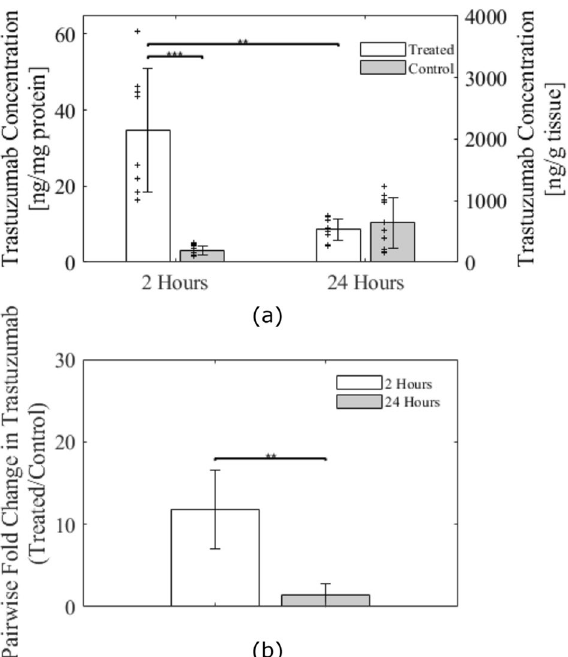
Figure 4. ELISA results for trastuzumab concentration in healthy rat spinal cord tissue. ( a ) Comparison between FUS-targeted regions and untargeted regions at 2-h post-FUS and 24-h post-FUS. Individual data plotted as ‘ +’ scatter points. ( b ) Fold increase in trastuzumab concentrations from untargeted to FUS-targeted region at 2-h and 24-h post-FUS. Significance was assessed on a 95% confidence interval. Error bars show standard